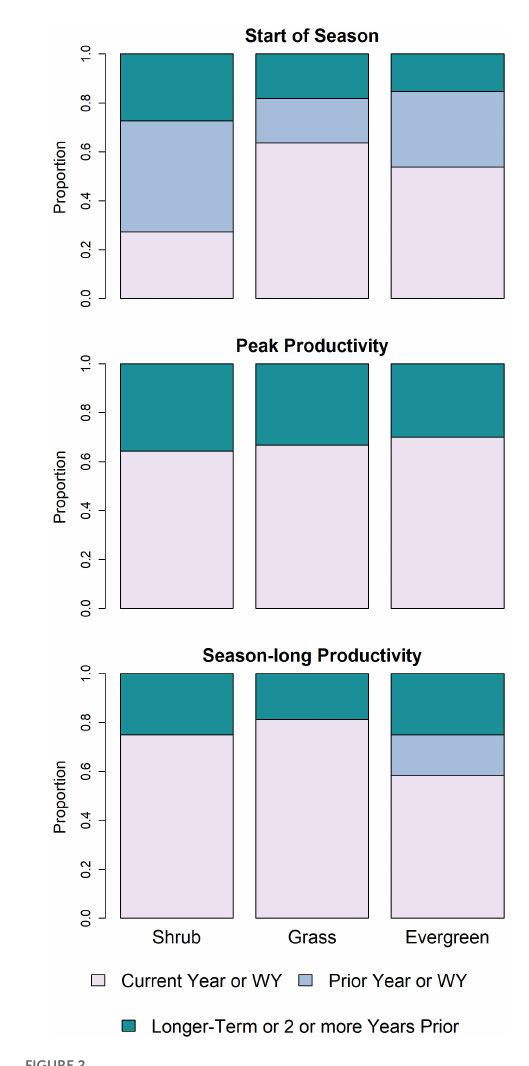
FIGURE2 Stacked bar plots indicating the temporal windows of predictor variables derived from a random forest variable selection approach used to identify a set of drivers strongly associated with phenological measures for a given land cover type. The temporal periods represent current, prior, and longer-term (i.e., multiple-year variables, or years/seasons 2 or more years prior to the current year) windows. Results are presented for three phenological measure for three predominant land cover types in the U.S. Northwestern Plains. WY, Water Year; Evergreen, Evergreen Forest.